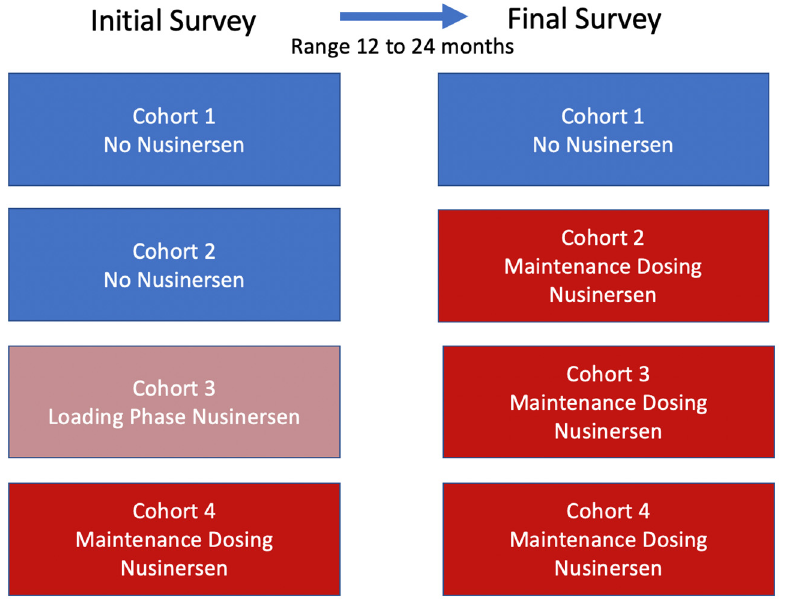
Figure 1. Nusinersen exposure at initial and final study timepoints. Legend—Transitions between nusinersen exposure during study initiation and follow-up timepoint including Cohort 1 which remained nusinersen naïve throughout; Cohort 2 which transitioned from no nusinersen to maintenance dosing; Cohort 3 which transitioned from loading phase to maintenance dosing; and Cohort 4 which remained on maintenance dosing with longest steady exposure to nusinersen.